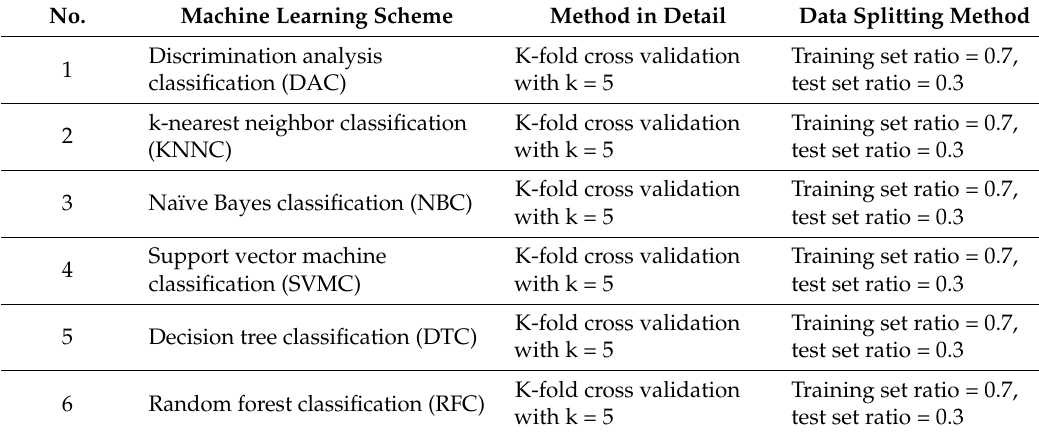
Table 1. Compared machine learning algorithms.